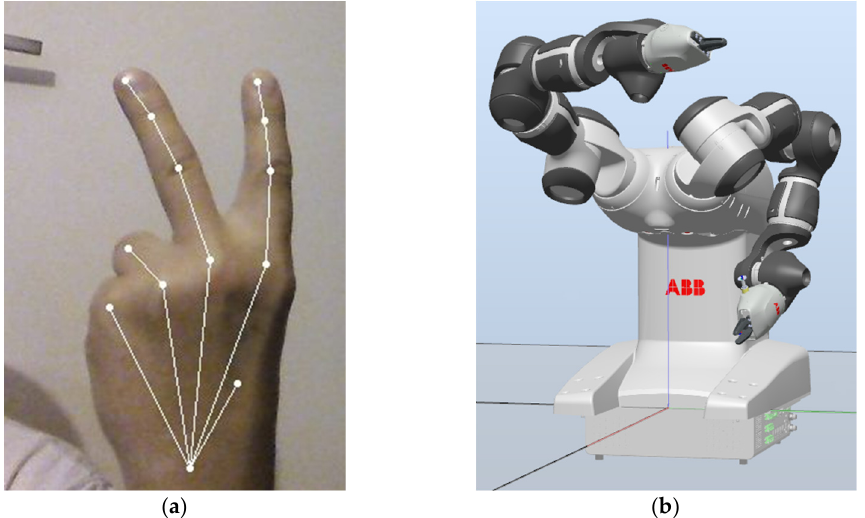
Figure 9. ( a ) Points on the hand with two outstretched fingers detected after data processing. ( b ) Movement of the robot arm to a given position for two outstretched fingers.